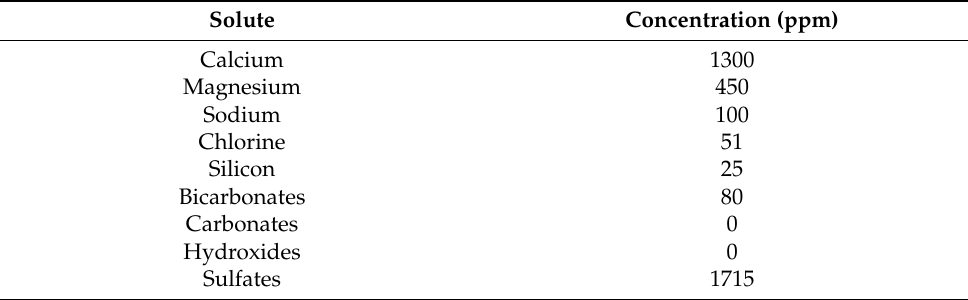
Table 1. Current composition of Naica